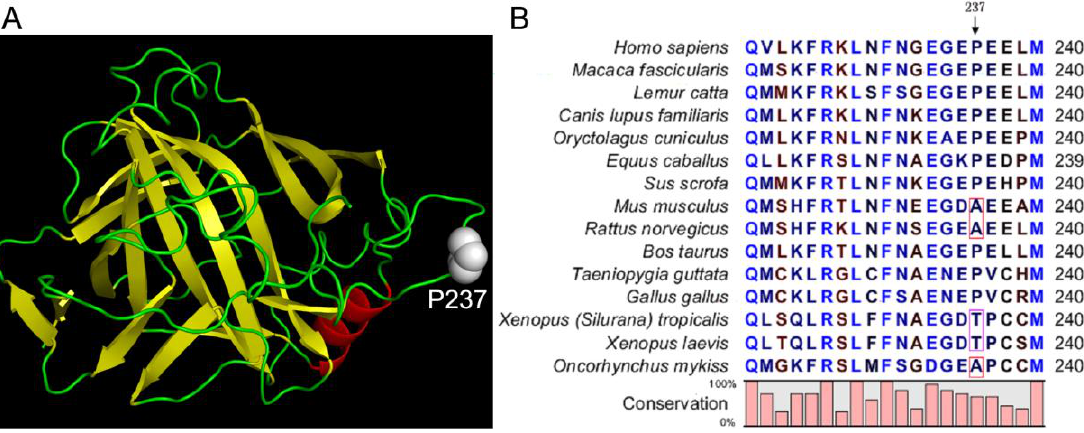
Figure 1. ( A ) Crystal structure of HCAII (PDB ID 2CBA). Pro237 is highlighted by space-filling model; ( B ) Sequence alignment of